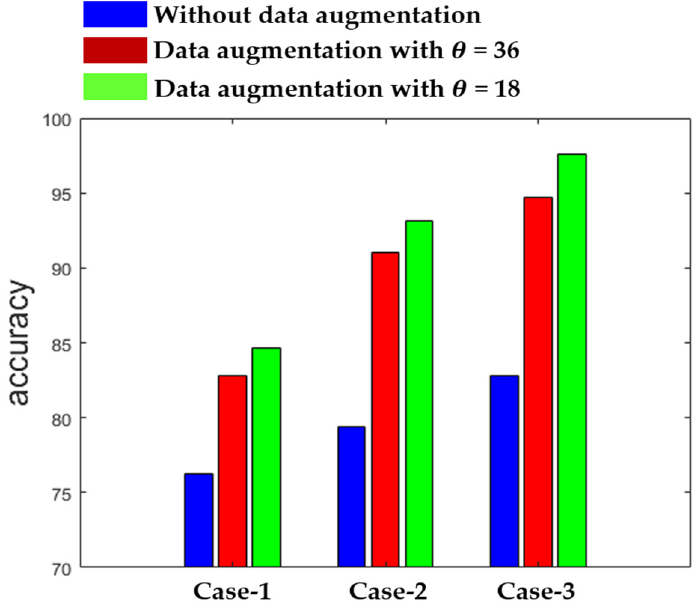
Figure 12. Clustering accuracy of the three networks.